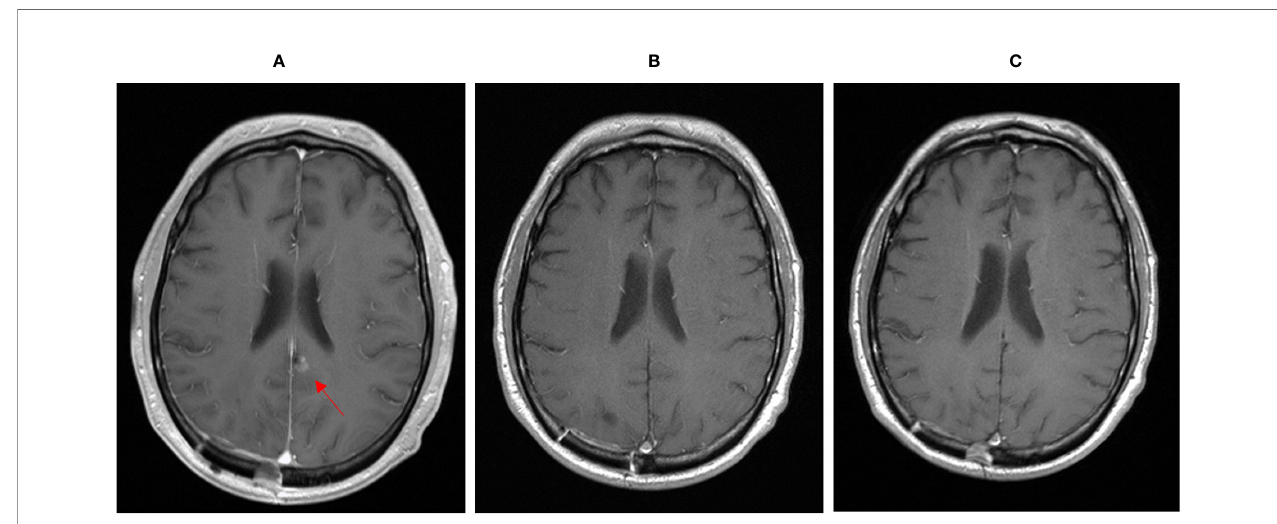
FIGURE 1 | MRI showing cerebral metastasis before (A) , after three month (B) and after one year (C) of double check point inhibition with ipilimumab and nivolumab.